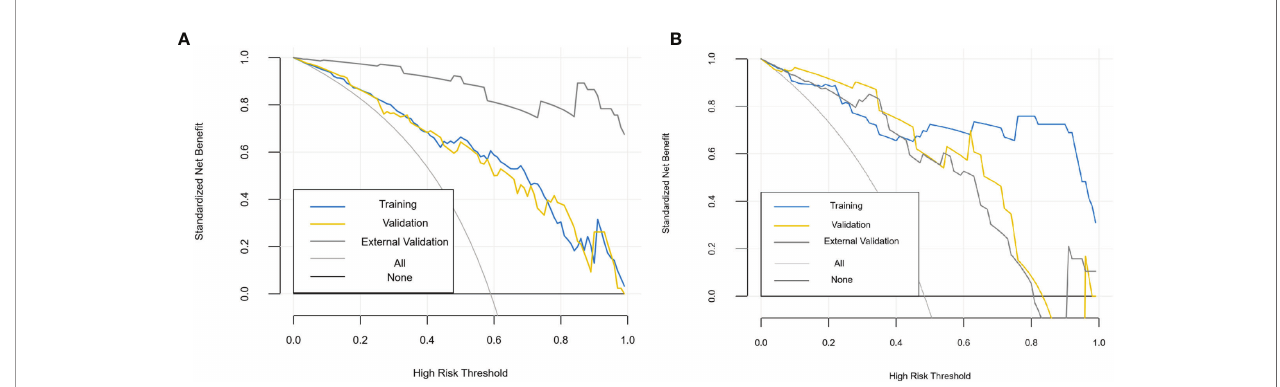
FIGURE 7 | Decision curves of MRI radiomics model (A) and Delta radiomics model (B) . The x-axis represents the probability of response to IC-CCRT, ranging from 0% to 100%; the y-axis measures the net bene fi t; the blue, yellow, and coarse gray lines represent nomograms of different groups. IC-CCRT, induction chemotherapy combined with